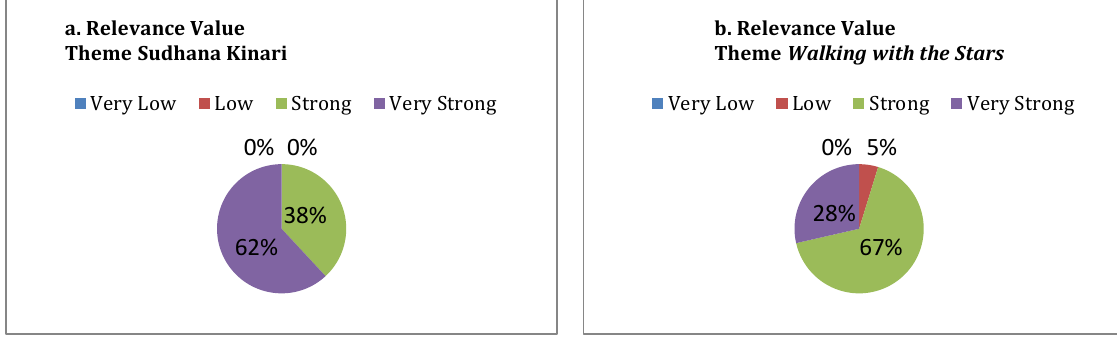
Fig. 6 Relevance Value Theme 1; a Sudhana Kinari , b Walking with the